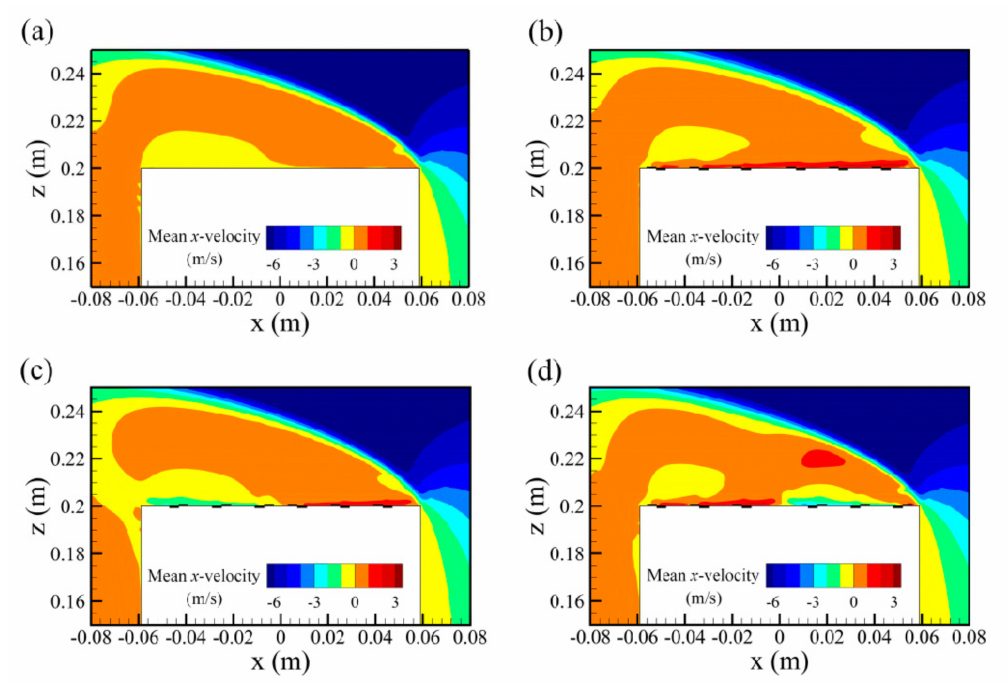
Figure 14. Contours of mean x -velocity component: ( a ) no actuation; ( b ) case A; ( c ) case B; ( d ) case C.